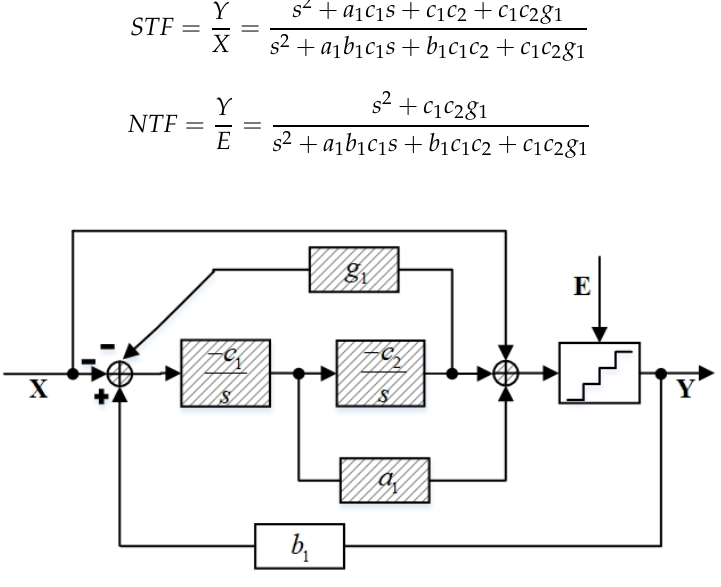
Figure 3. Architecture of the single-loop second-order ΣΔ modulator.